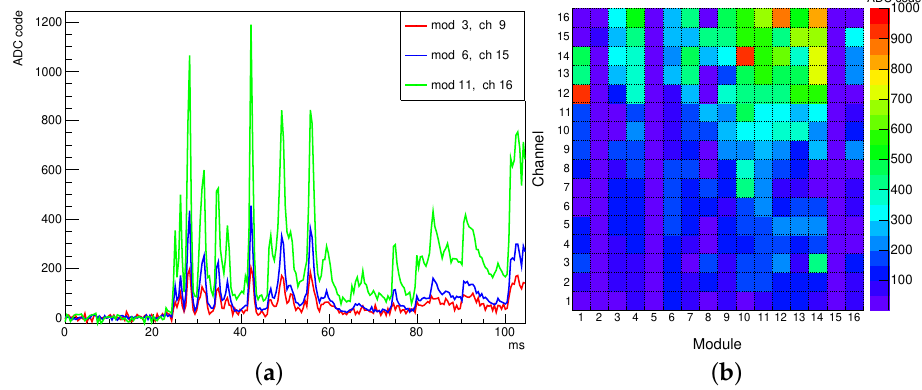
Figure 12. UV flash with a complicated temporal structure ( a ) and a map of pixels for this event ( b